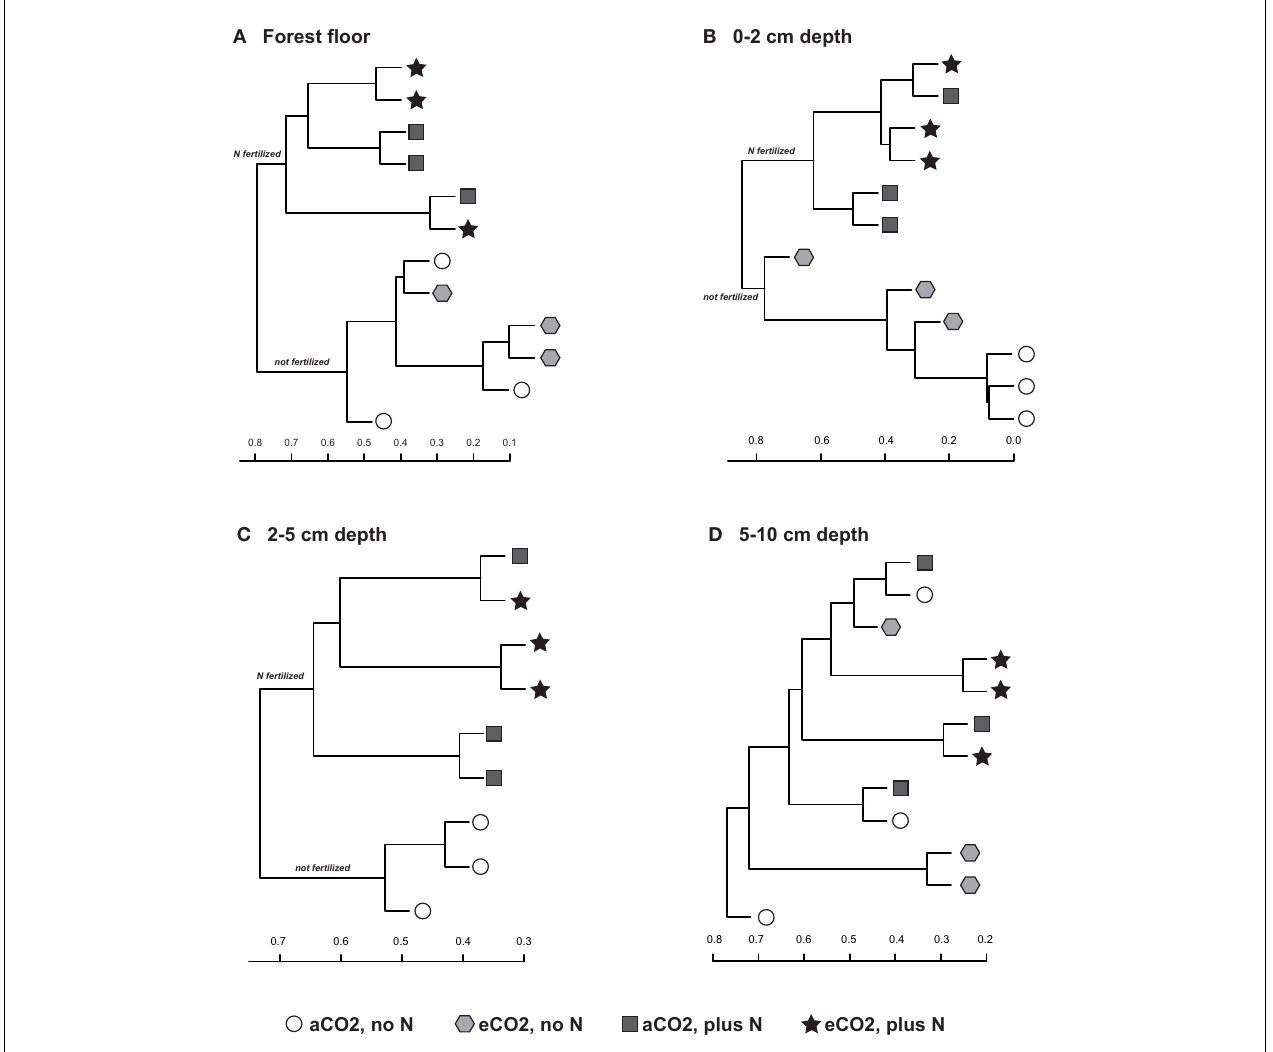
FIGURE 3 |Agglomerative hierarchical clustering dendrograms based on the Bray–Curtis distance metric (taking relative abundance into account) and the percent representation of fungal family in each library for the (A) forest floor, (B) 0–2cm, (C) 2–5cm, and (D) 5–10cm depth intervals.